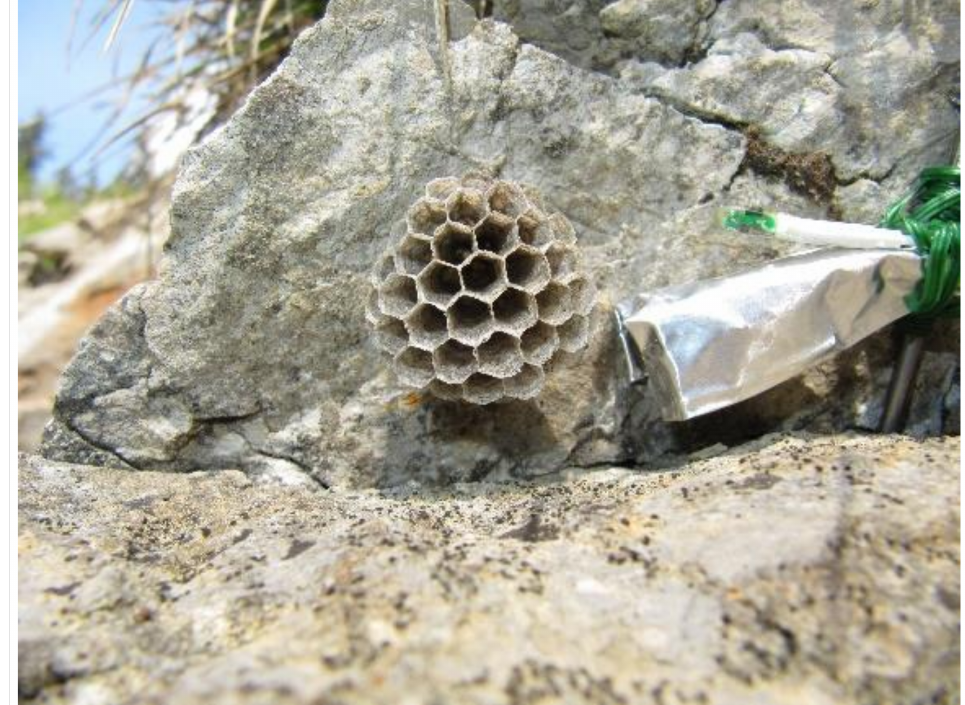
Figure 1. Nest of Polistes biglumis provided with a temperature and radiation sensor. The temperature sensor is protected from the solar